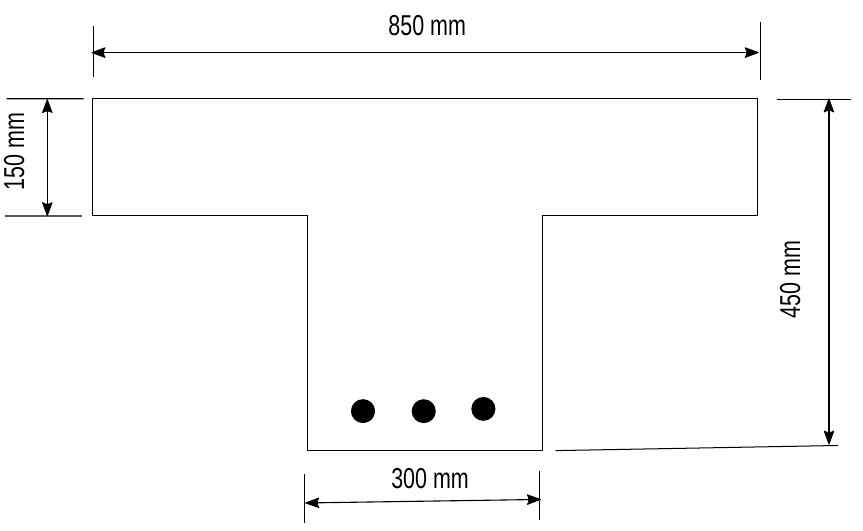
Figure 3. Cross-section of bridge